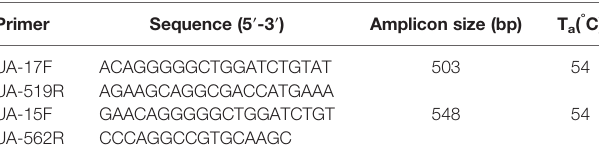
TABLE 2 | Primers developed in the present